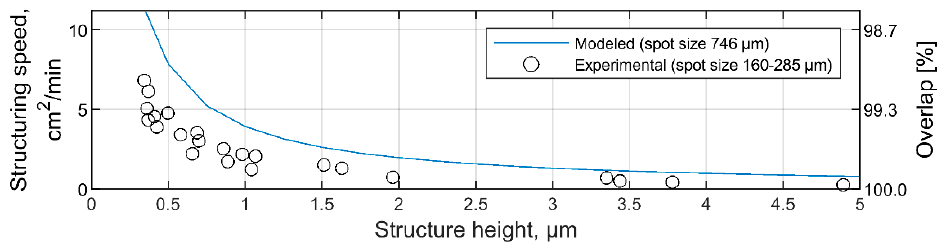
Figure 7. Maximal calculated ( blue line ) and experimental ( empty circles ) structuring speeds for a